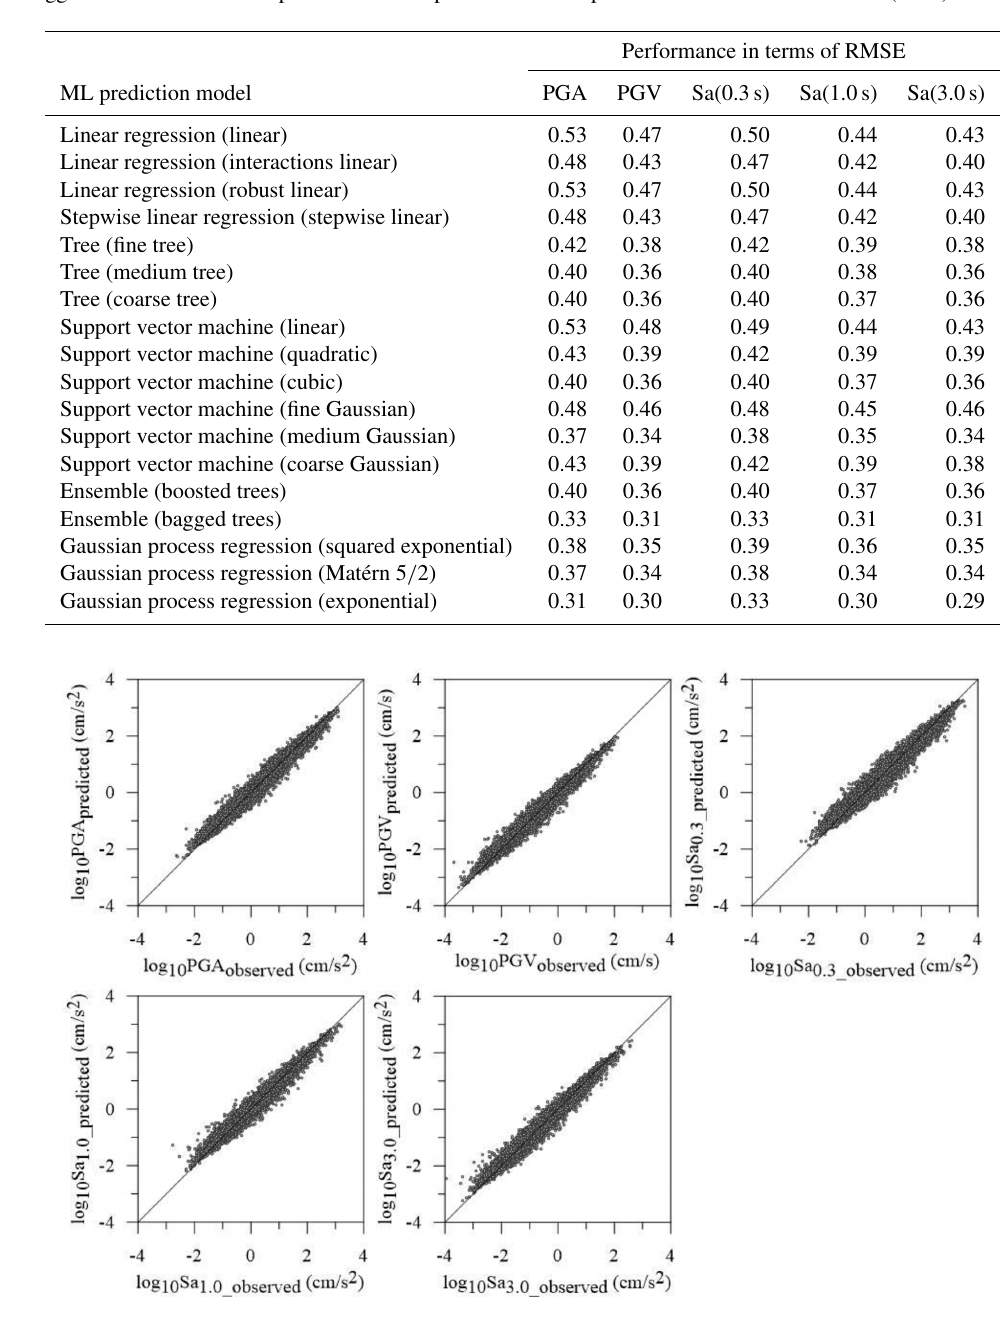
Table 2. RMSE for all ML prediction models used to forecast the log 10 geometric horizontal mean (geoH) of PGA, PGV, and Sa at 0.3, 1.0, and 3.0s. The suggested reference for comprehensive descriptions of the ML prediction models is MathWorks (2019).